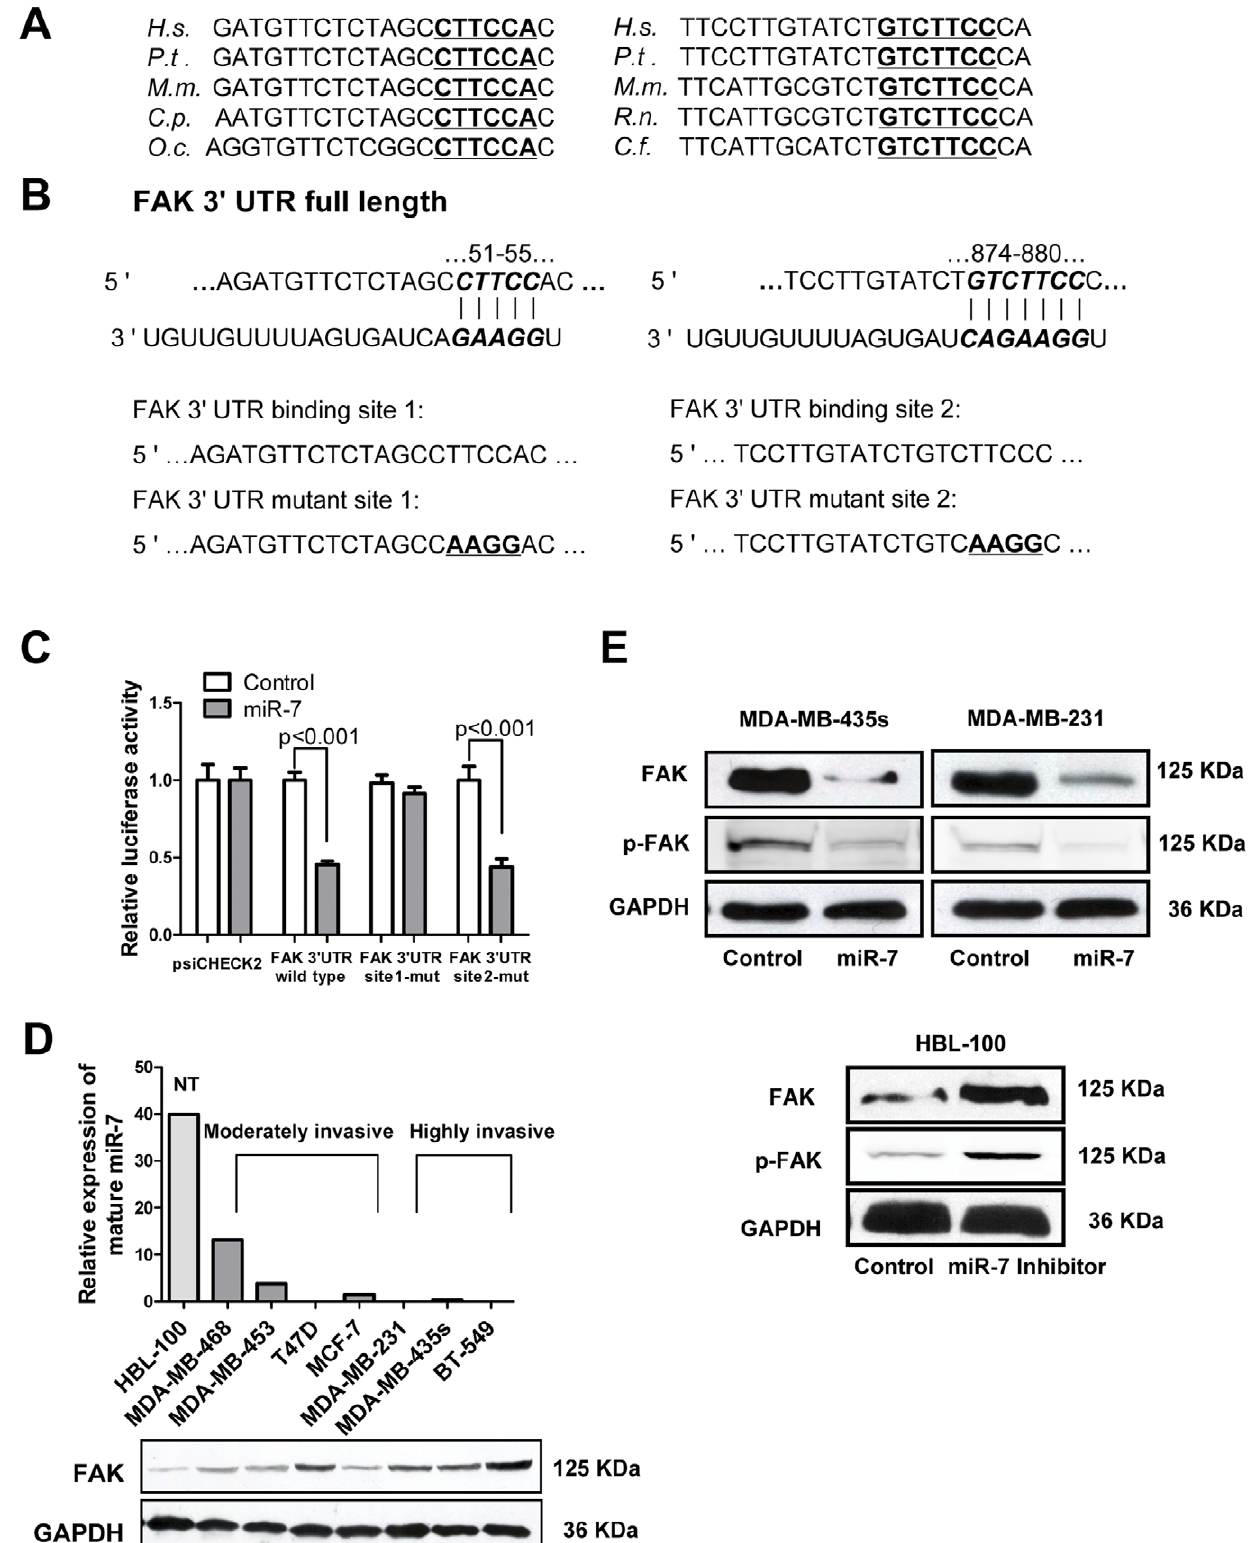
Figure 2. miR-7 decreases FAK expression by directly targeting its 3 9 -UTR. (A) The potential binding sequences for miR-7 within the FAK 3 9 - UTR of human (H.s), chimpanzee (P.t), mouse (M.m), guinea pig (C.p), rabbit (O.c), rat (R.n), and dog (C.f). Seed sequences are highlighted and underlined. (B) Luciferase reporter plasmids were constructed by the insertion of full length FAK 3 9 -UTR into the region immediately downstream of the luciferase gene. The sequences of two predicted miR-7 binding sites within the FAK 3 9 -UTR, including wild-type full-length UTR or mutant